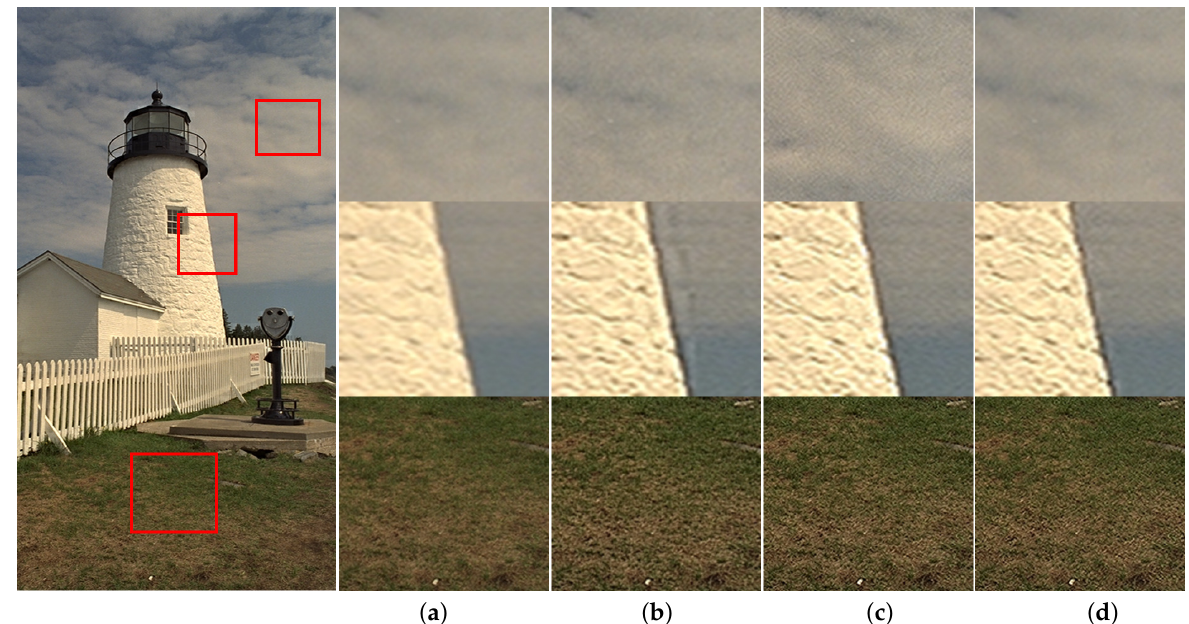
Figure 9. Comparison of enhancement results at plane, edge and texture. ( a ) The original images. ( b ) By the MESM method. ( c ) By the CWM method. ( d ) By the proposed